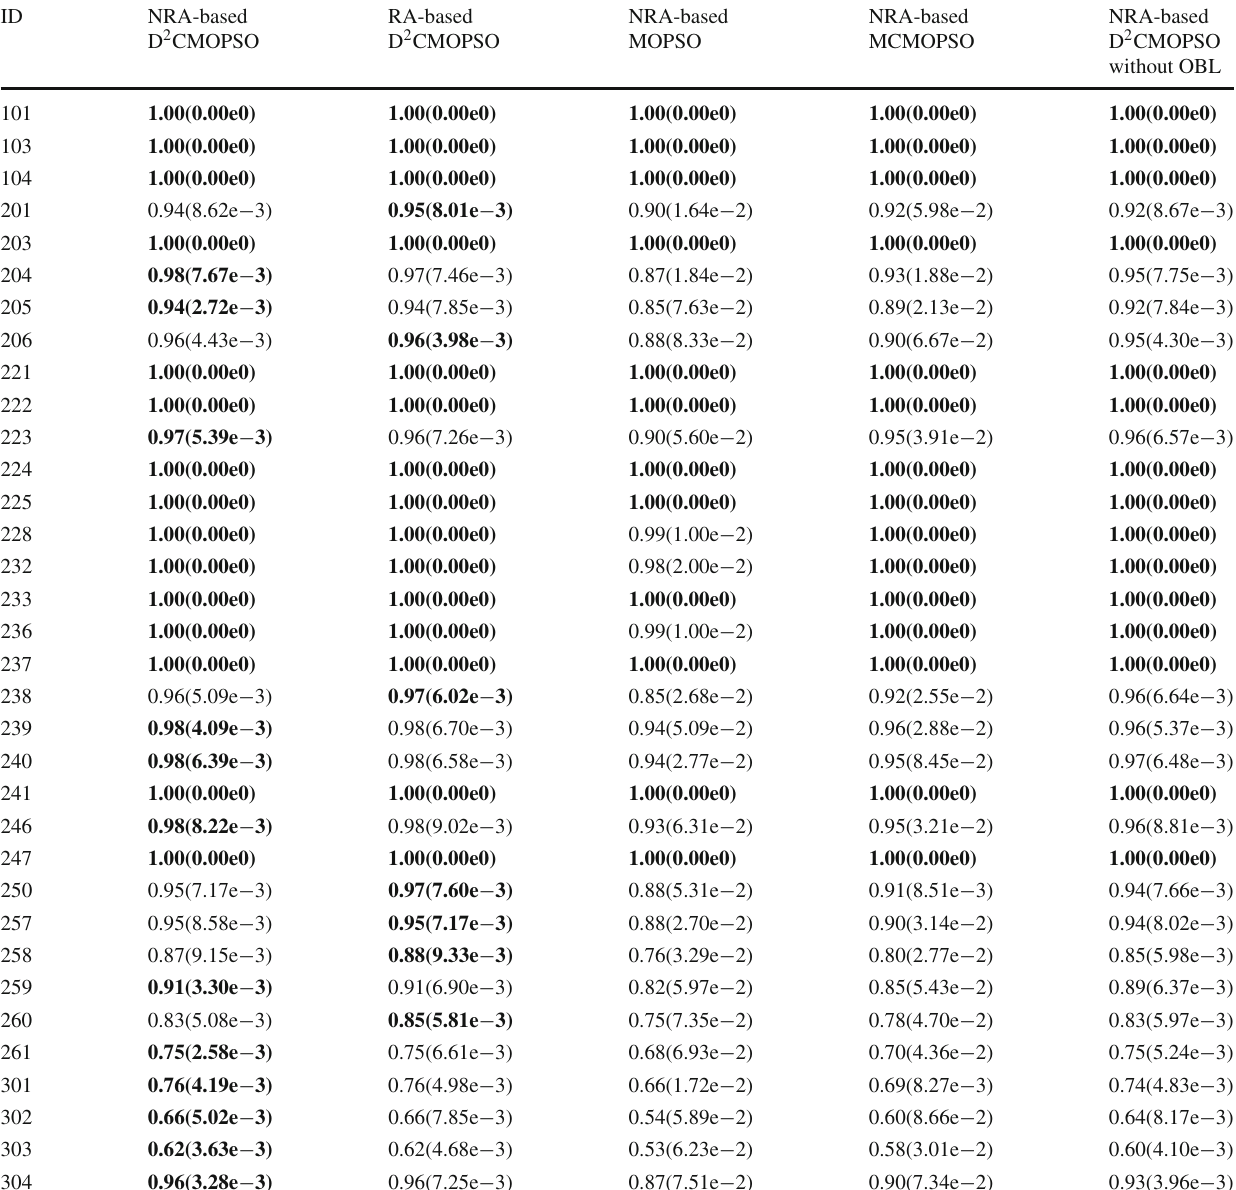
Table 9 HV values of different matching systems in benchmark